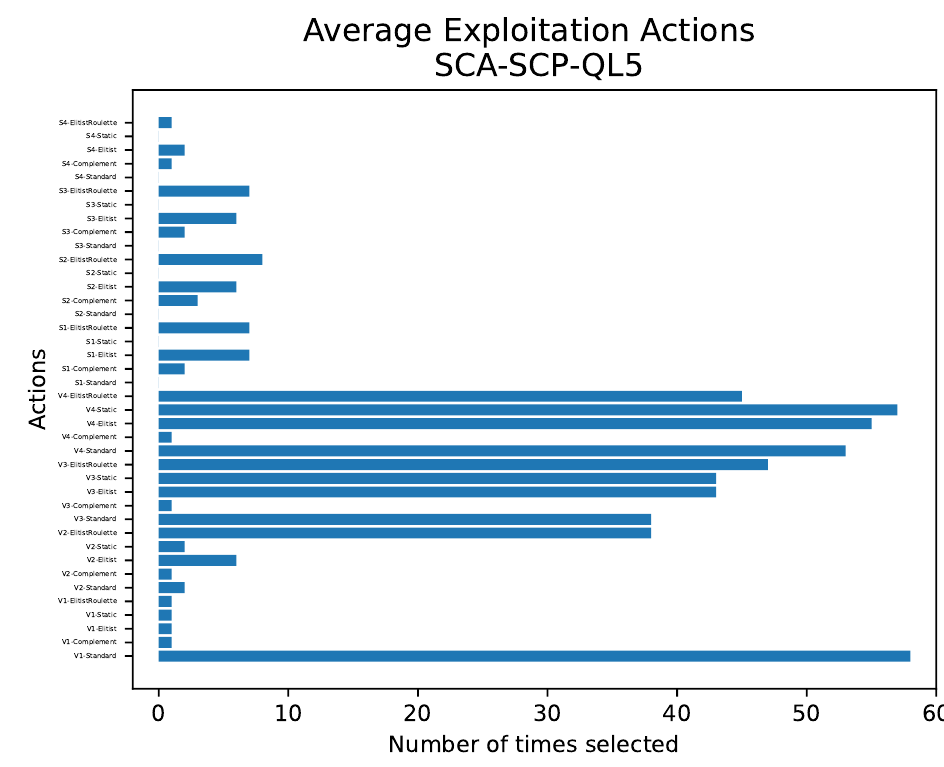
Figure 8. SCA-QL5—The average number of actions in the exploitation state.